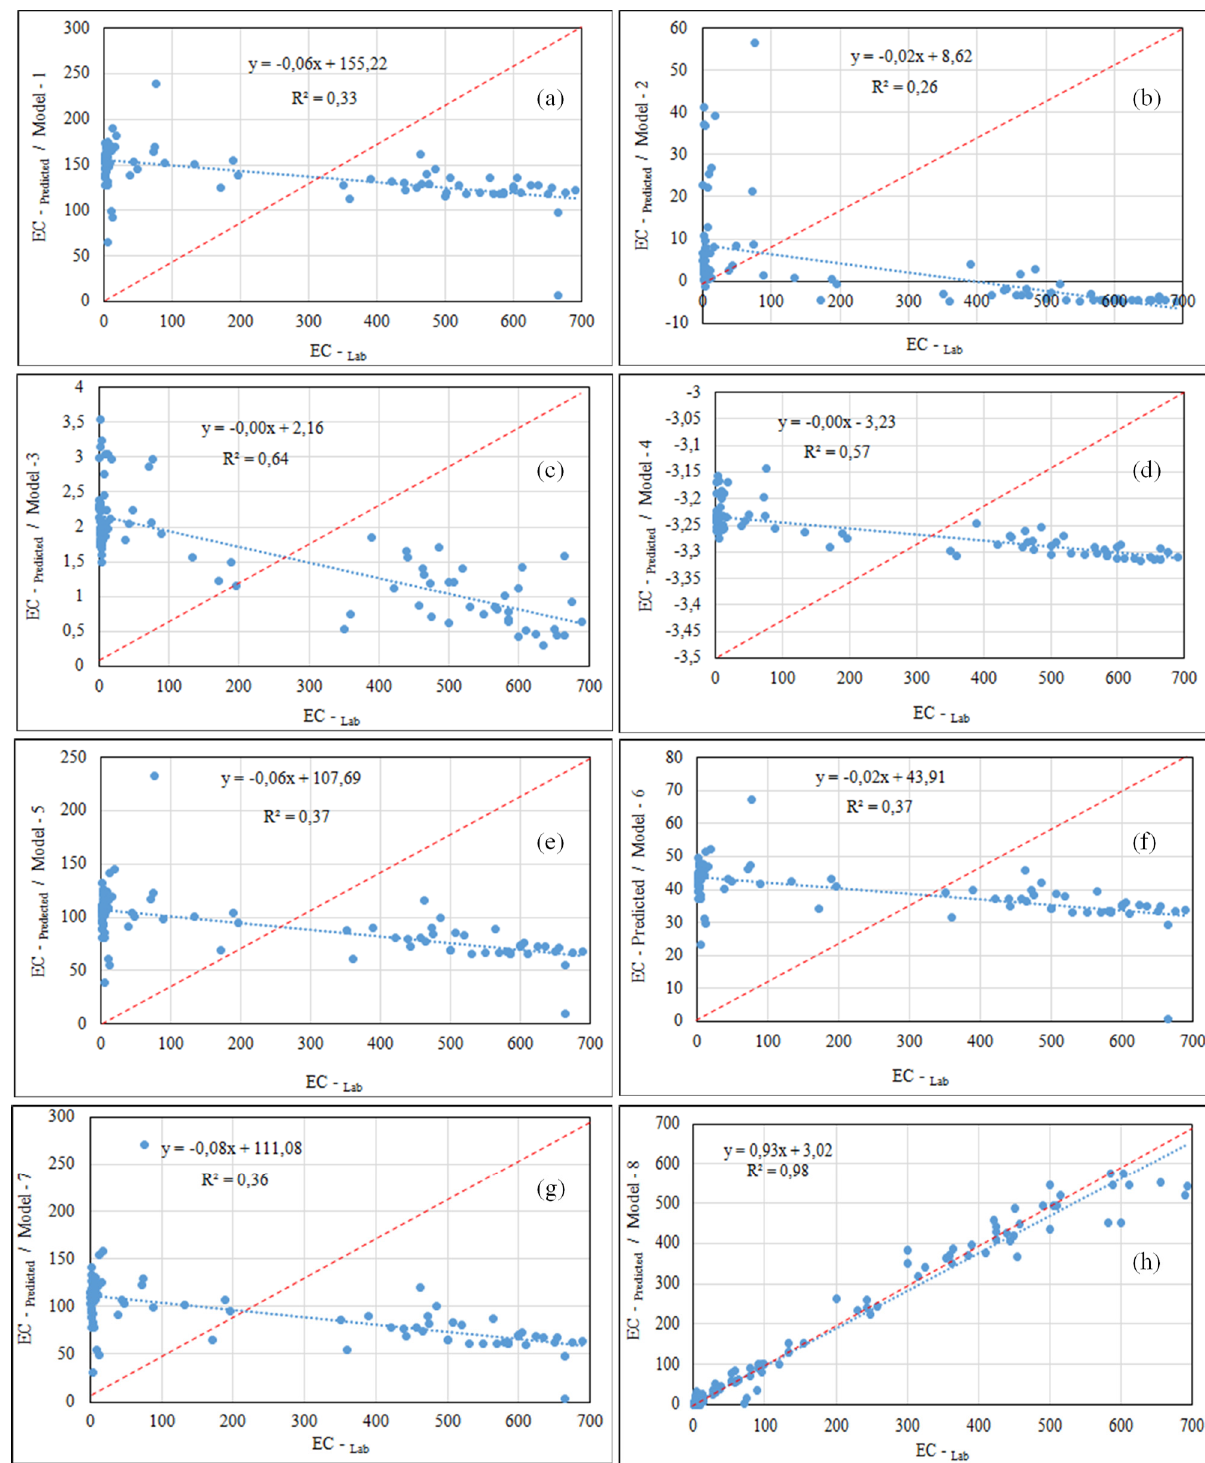
Figure 7. Relationship between EC- Lab and predicted salinity (EC- Predicted ) derived from models based on simulated data.